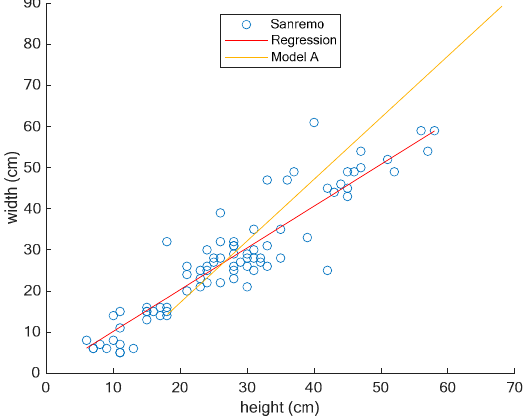
Figure 6. Height and width of the Eunicella verrucosa colonies off Sanremo, with linear regression (red line). In yellow the regression from model A [33].